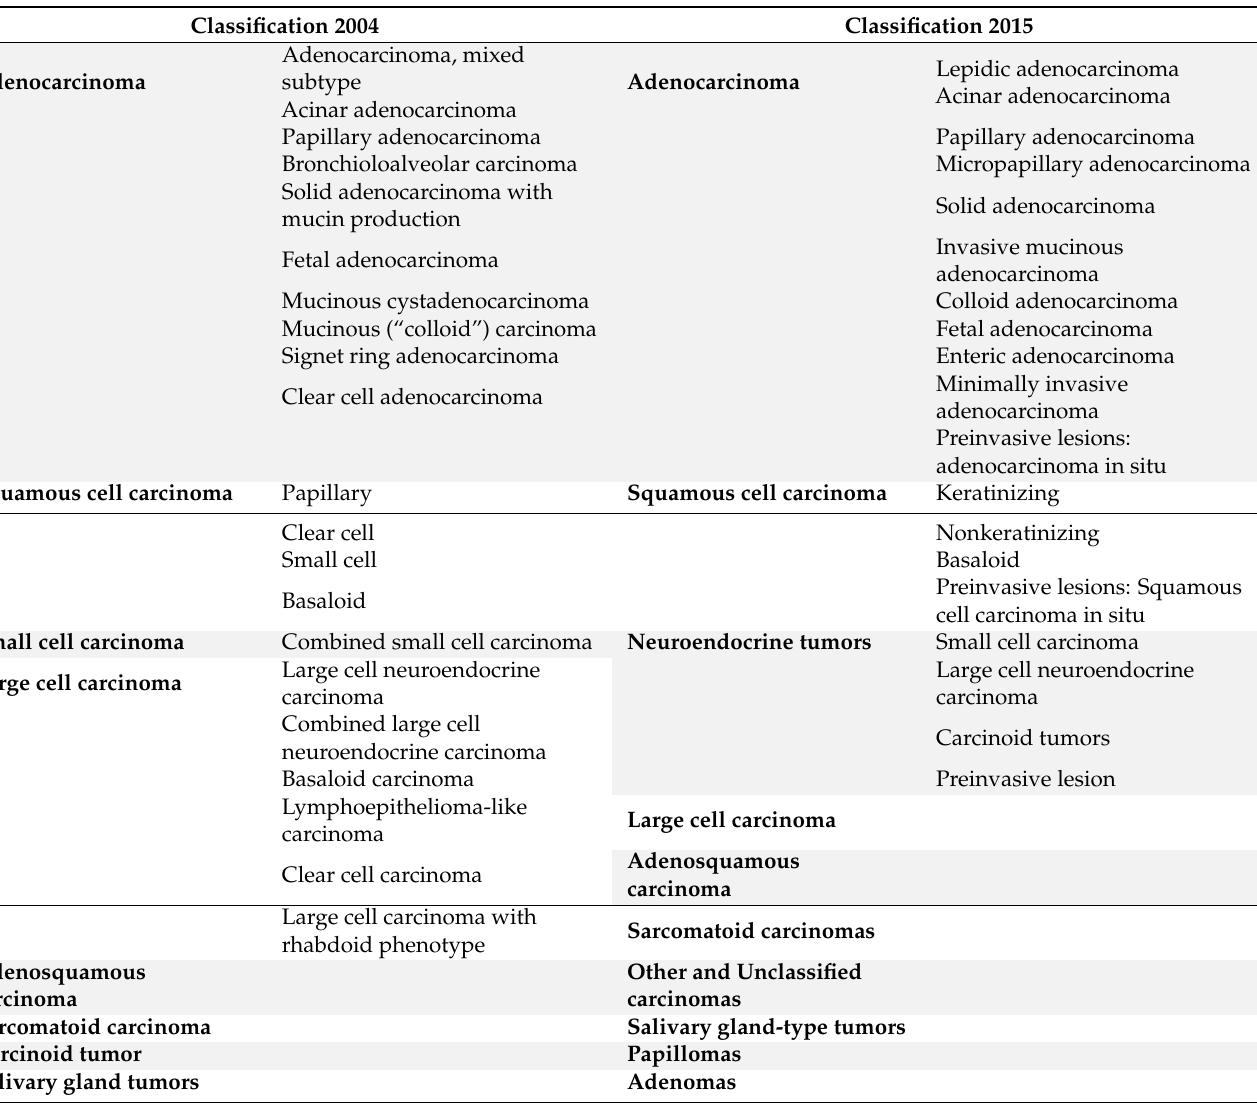
Table 1. Comparison of previous and new histopathological classifications of lung cancer, published by the World Health Organization [42]. While NSCLC does not exist in histopathological classification, in general use, it comprises: adenocarcinoma, squamous cell carcinoma, and large cell